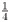
Sensitivity of β(t) estimation error to the user-specified values of input parameters.[Panel A] Median RRMSE (Eq (33)) in estimates of β(t) from simulated reported incidence time series (Δt = 1 week, n = 1042), as a univariate function of the factor by which an input parameter was mis-specified. One thousand simulations were performed using fixed values (Table 1) for all data-generating parameters. The simulations accounted for environmental stochasticity [ES] (ϵ = 0.5), demographic stochasticity [DS], and observation error [OE] (prep = 0.25, trep = 2 weeks). For each simulation, corresponding mock birth and natural mortality time series were created, and β(t) was estimated from the data using the SI method. True (data-generating) values were specified for all input parameters except the focal parameter (indicated by the legend), for which 41 values logarithmically spaced between 14 and 4 times the true value were specified in turn. Each input parametrization yielded 1000 estimates of β(t), whose median RRMSE was calculated (after smoothing with fixed q; see Eq (59)) and displayed as one point in the appropriate graph. [Panel B] Result of repeating the analysis from Panel A in which S0 was specified with varying amounts of error, but with the initially erroneous value of S0 updated using the method of peak-to-peak iteration (PTPI; 25 iterations) prior to β(t) estimation. The original result, obtained without PTPI, is presented for comparison.